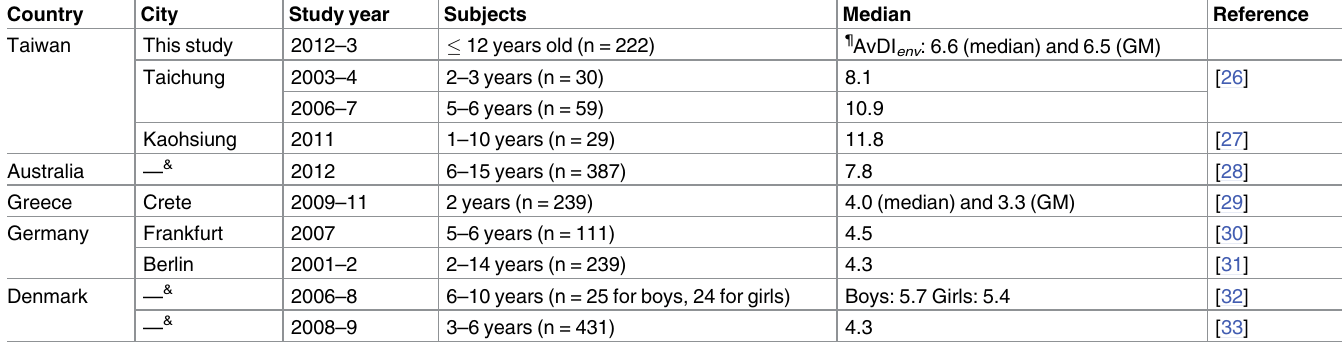
Table 4. Median or geometric mean (GM) of estimated DEHP daily intake levels ( μ g/kg bw/day) in different